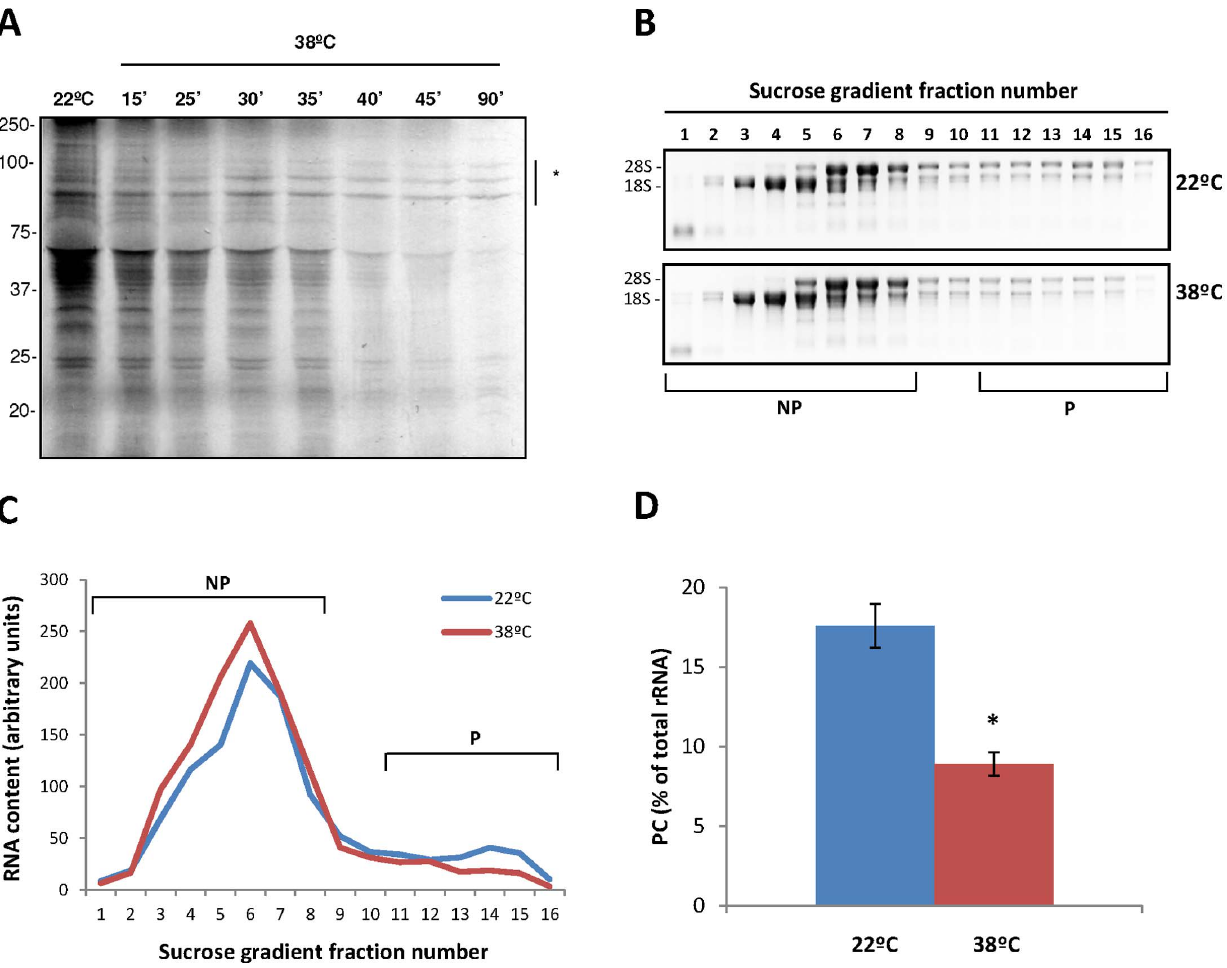
Figure 1. Heat triggers a general inhibition of protein synthesis. ( A ) Metabolic labeling of de novo synthesized proteins from Arabidopsis seedlings grown at 22 u C or after a heat shock of 38 u C during the indicated times. High molecular weight heat-shock proteins are indicated by an asterisk. ( B ) Verification of the quality of the polysome preparation. Equal volumes of the last 16 fractions of the sucrose gradient from control or heat-stressed Arabidopsis seedlings were subjected to electrophoretic analysis. According to the distribution of 18 S and 28 S rRNAs, fractions 1–8 were designated as non-polysomal (NP), while fractions 11–16 were considered as polysomal (HP) fractions. ( C ) Quantification and graphic representation of the polysome profiles from the samples in (B). ( D ) Polysome content (PC) of control or heat-stressed Arabidopsis seedlings was calculated as described in materials and methods. Values are mean percentages from three biological samples (*P , 0.05).